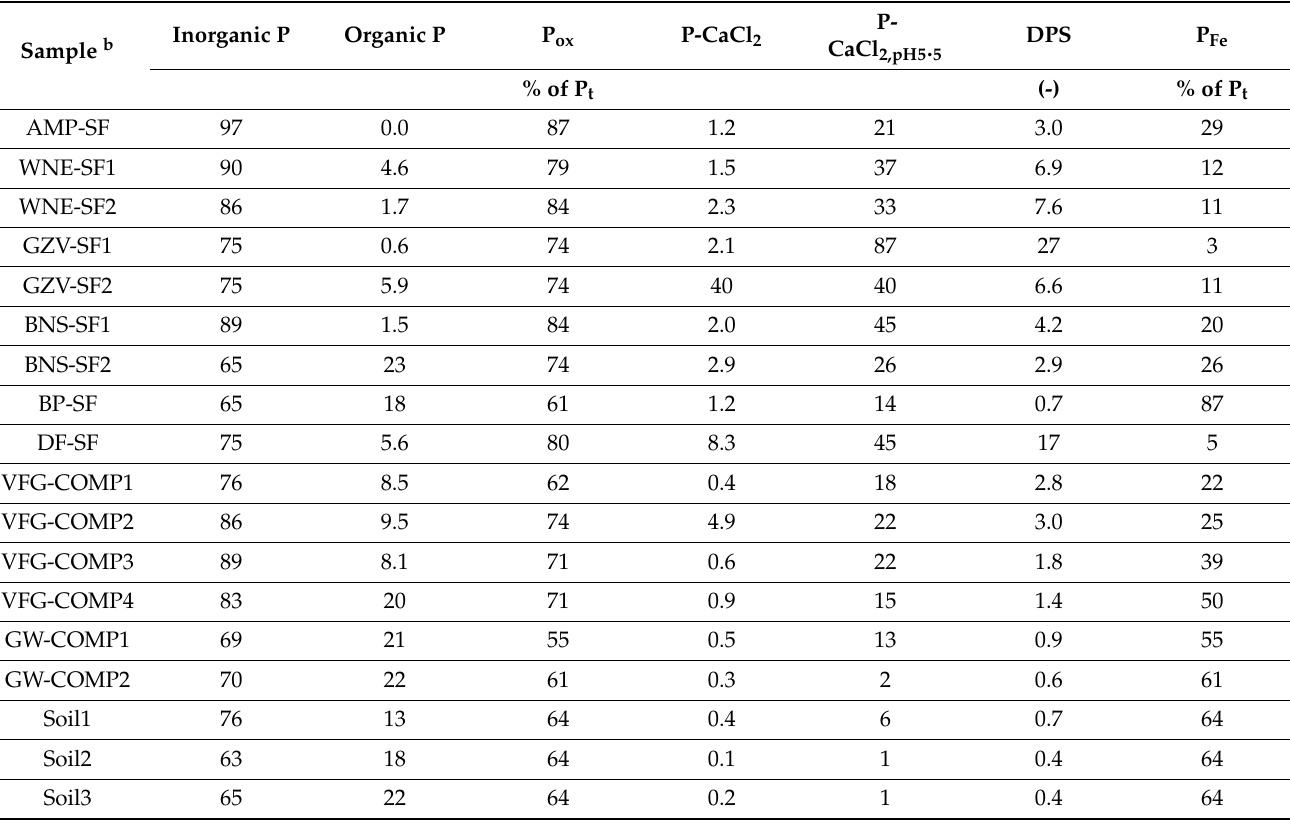
Table 4. Percentage distribution of total P (P t ) over the distinguished P species as well as the degree of P saturation (DPS) of the Fe/Al oxides a